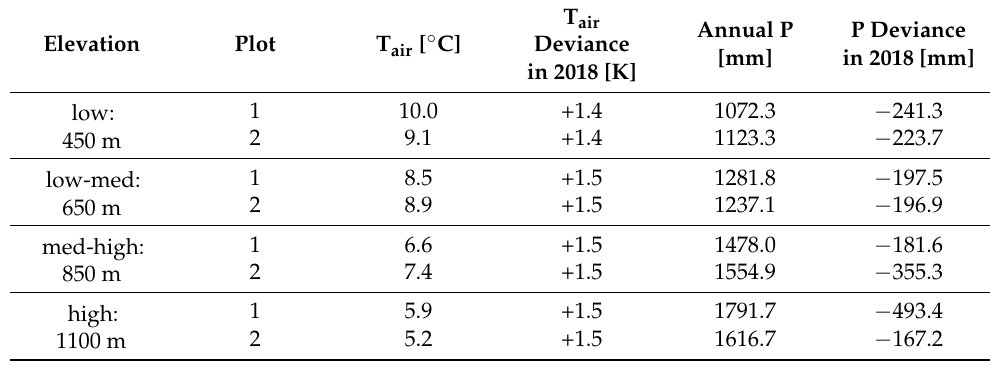
Table 2. Mean annual air temperature (T air ) and cumulative precipitation sum (P) and the anomalies in the year 2018 compared to the long-term mean for each plot per elevation.